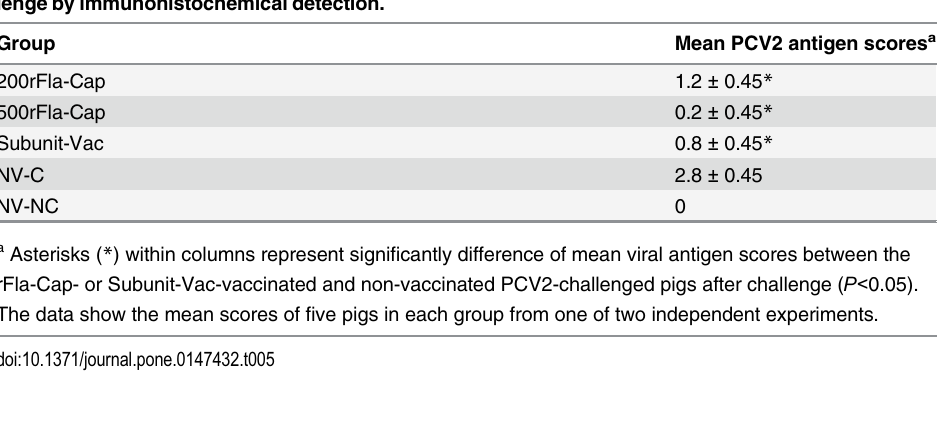
Table 5. PCV2 antigen scores for inguinal lymph nodes of rFl-Cap vaccinated pigs after PCV2 chal- lenge by immunohistochemical detection.